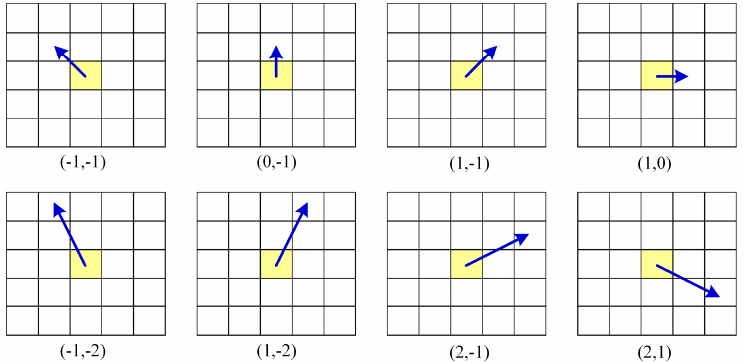
Figure 3. Eight displacement vectors used for producing a disparity gradient index (DGI) image.